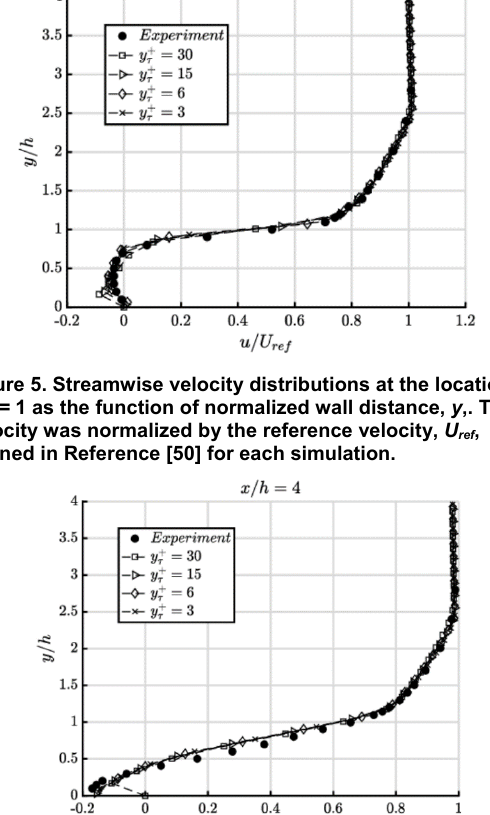
Figure 6. Streamwise velocity distributions at the location x/h = 4 as the function of normalized wall distance, y ,. The velocity was normalized by the reference velocity, U ref , defined in Reference [50] for each simulation.